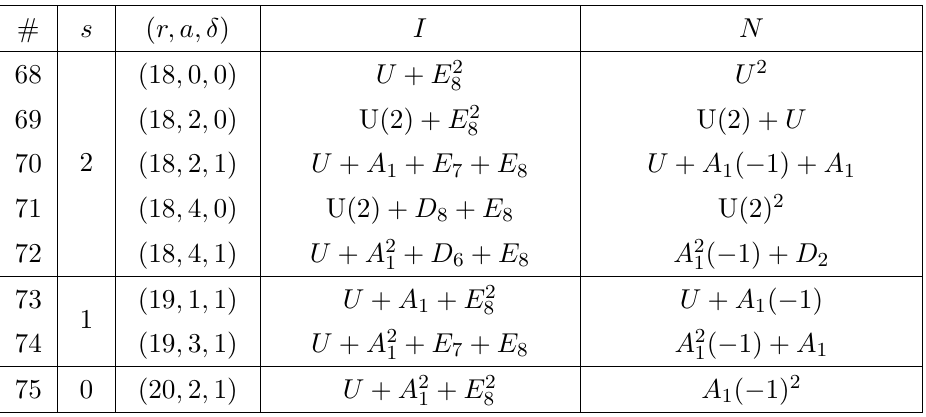
Table 1. Summary of invariant and normal lattices corresponding to each point in figure